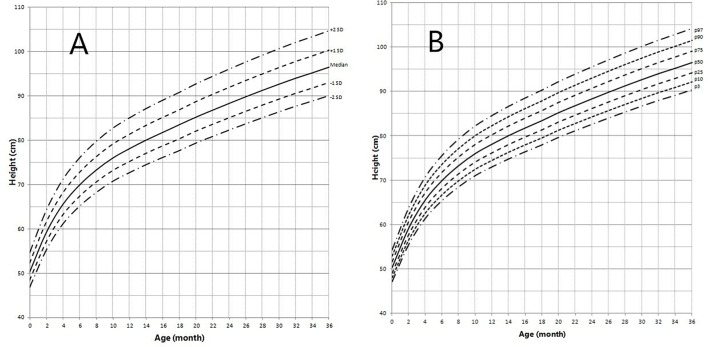
Height in children with 5αRD (0–36 months old). (A) Standard deviation curve; (B) Percentile curve.